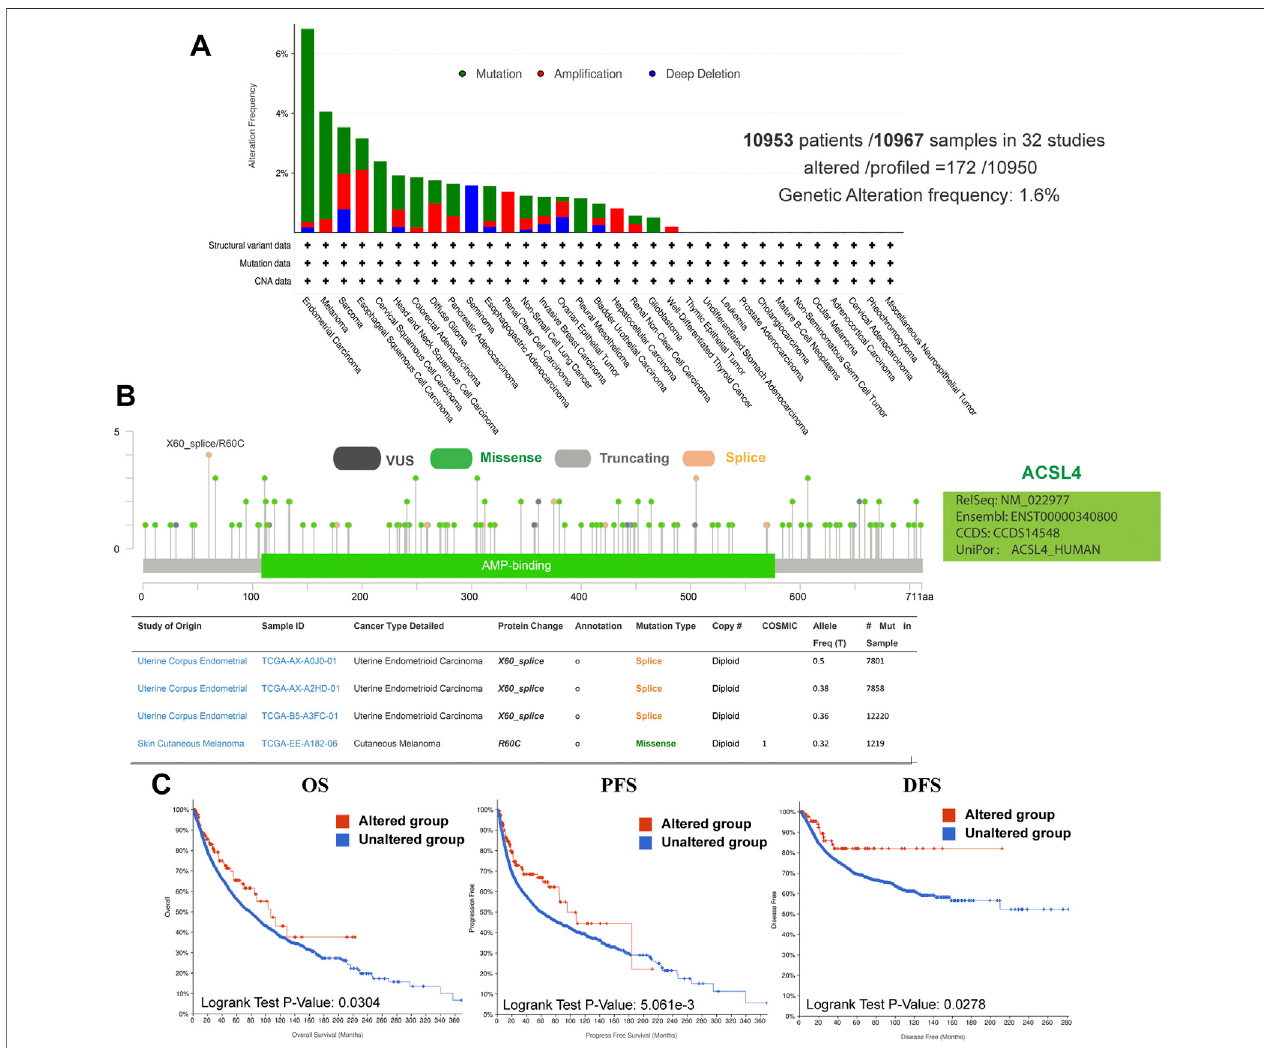
FIGURE 4 | Genetic alterations of ACSL4 in different cancers from the cBioPortal database. (A) . Genetic aberration of ACSL4 in tumors using cBioPortal-TCGA pan-cancer panel. This data includes 10953 patients/10967 samples in 32 studies. The global genetic alteration frequency is 1.6%. (B) . The types and mutation sites of ACSL4 gene. (C) . Correlation between ACSL4 altered and prognosis of various types of cancer. OS of pan-cancer in 32 studies ( n (cid:1) 10803); PFS of pan-cancer ( n (cid:1) 10613) in 32 studies; DFS of pan-cancer ( n (cid:1) 5383) in 32 studies. OS, overall survival; PFS, Progression-free survival; DFS, Disease-free survival.